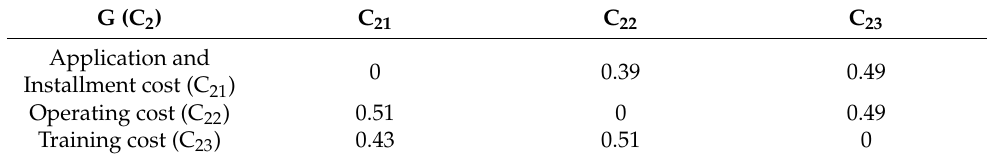
Table 12. Normalized direct influence matrix T between Economical (C 2 )